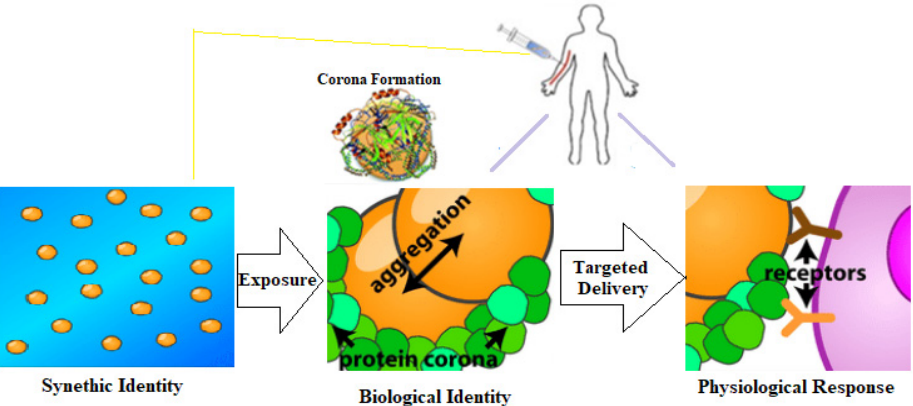
Figure 3. The interaction between protein corona, NP, and cellular receptors (physiological reactions). After NP injection into the blood, protein corona starts to aggregate at the NP surface as a part of biological identity. After that, cellular response can be triggered by specific protein receptors at the cell surface [44,45].